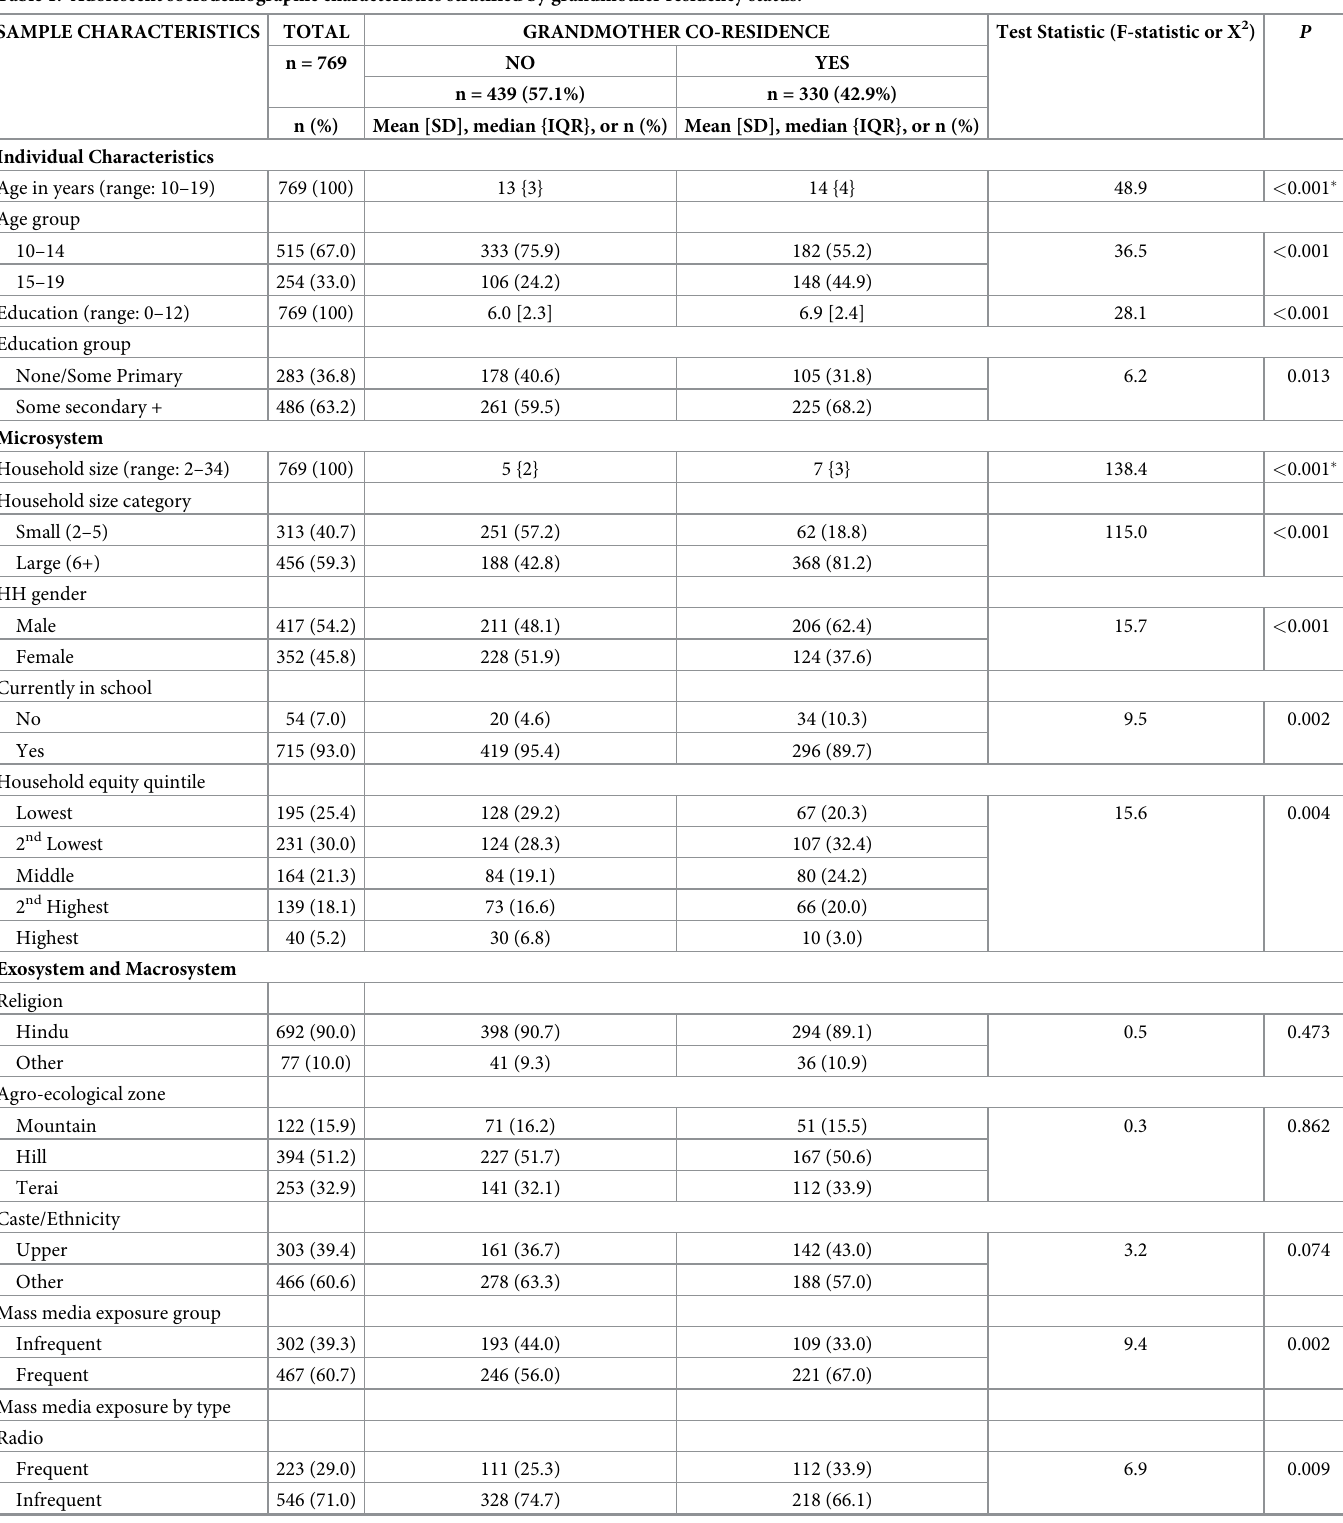
Table 1. Adolescent sociodemographic characteristics stratified by grandmother residency